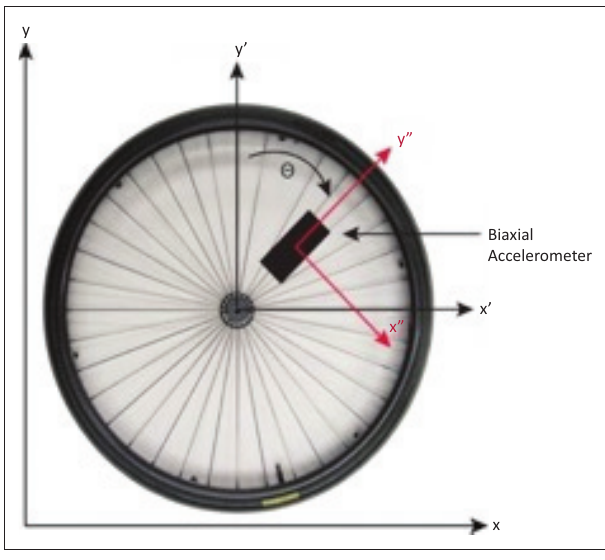
FIGURE 4: Orientation of spoke-mounted